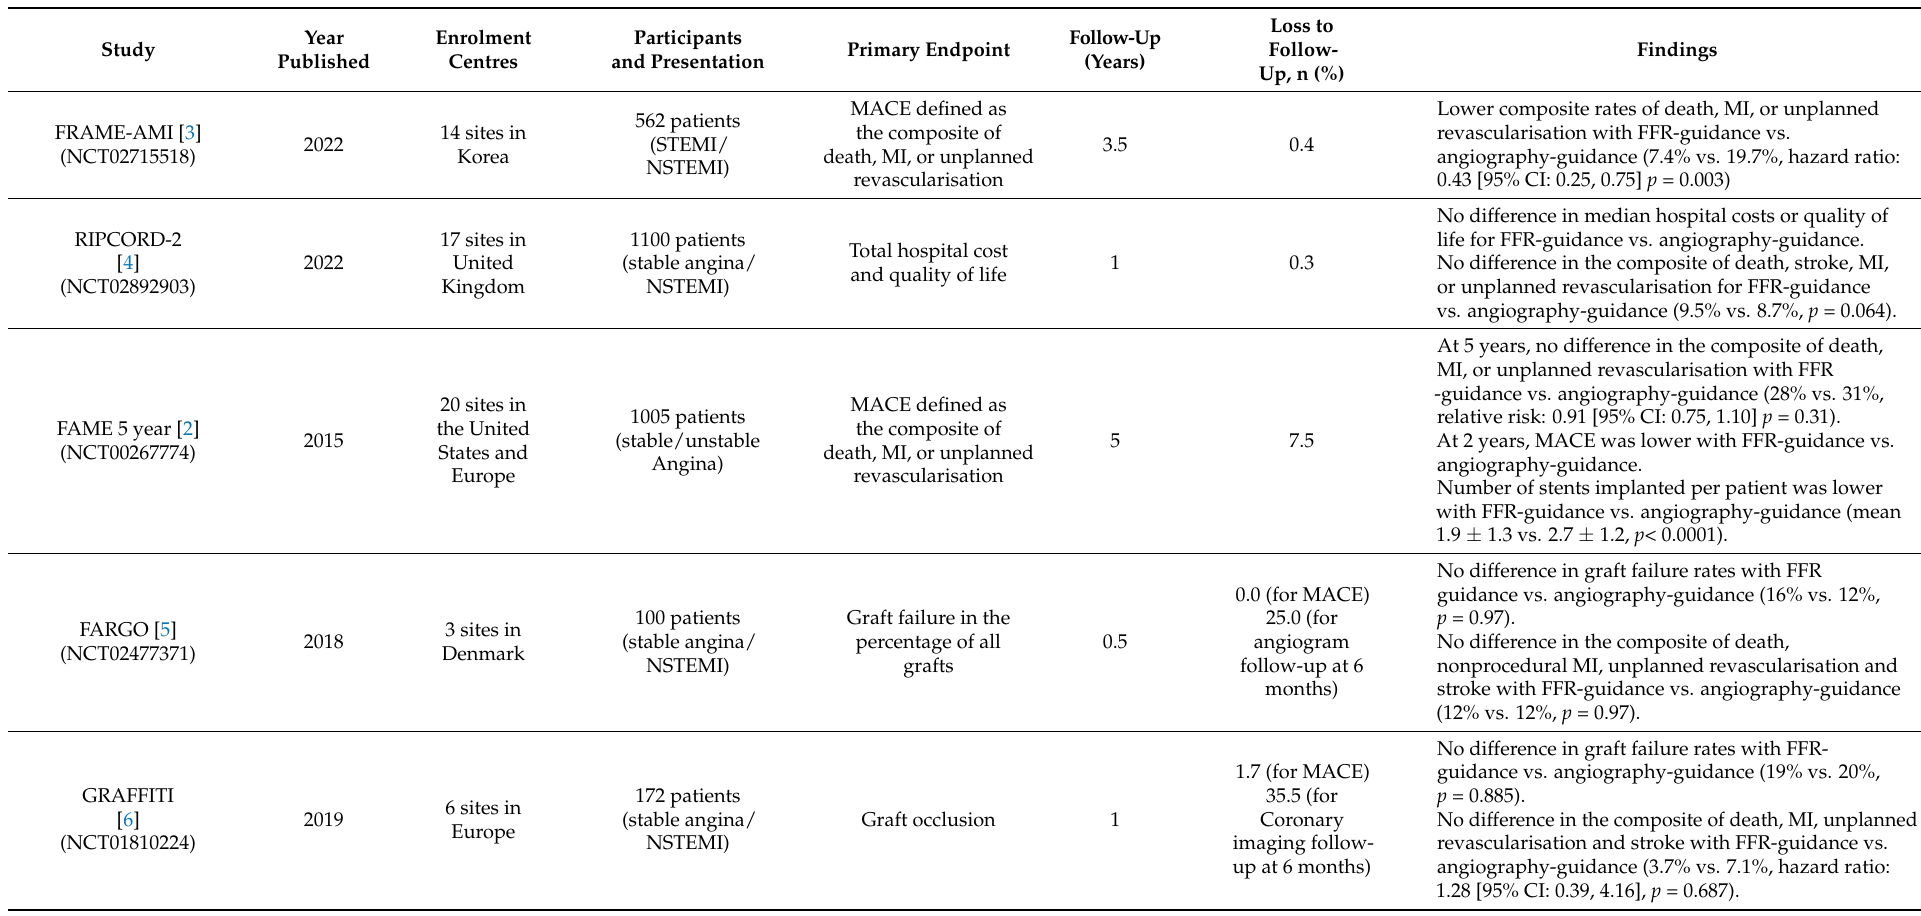
Table 1. Characteristics of RCTs, comparing FFR with angiography, for guiding